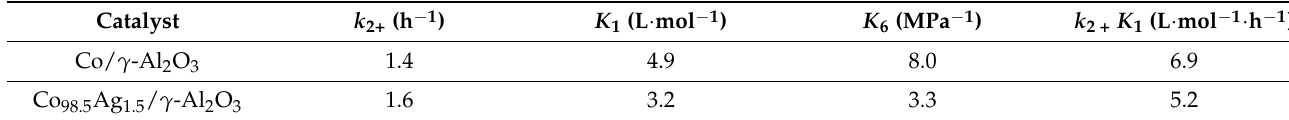
Table 2. Regressed kinetic parameters for ammonolysis of ethylene glycol on Co/ γ -Al 2 O 3 and Co 98.5 Ag 1.5 / γ -Al 2 O 3 catalysts (Co 5 wt%) at 453 K.